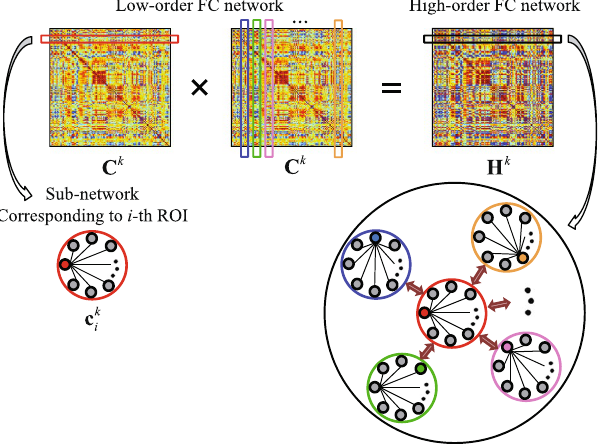
Figure 9. Illustration of high-order FC network construction based on the topographical similarity between each pair of the low-order sub-networks. The high-order FC network is built in a dynamic way using the k -th rs- fMRI time subseries ( = … k K 1, 2, , ).